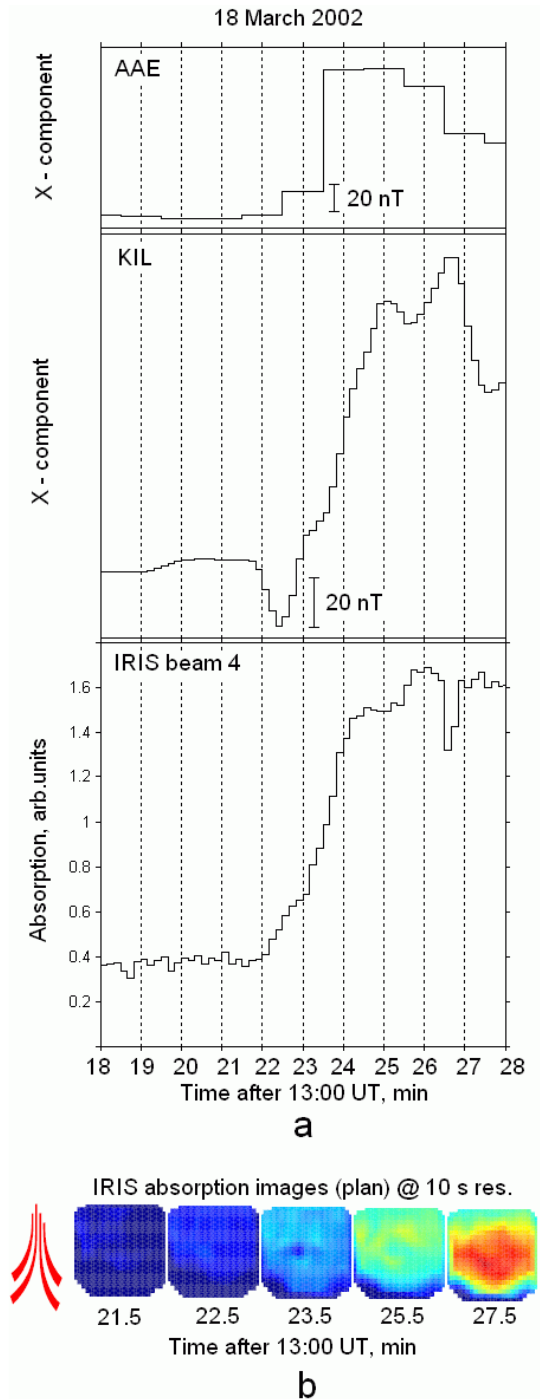
Fig. 4. (a) Negative magnetic deviation and SCA observed at high latitudes 1min before the main impulse at equatorial station AAE; (b) two-dimensional “portrait” of sudden commencement absorp- tion in the IRIS field of